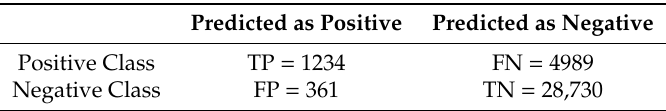
Table 2. Confusion matrix